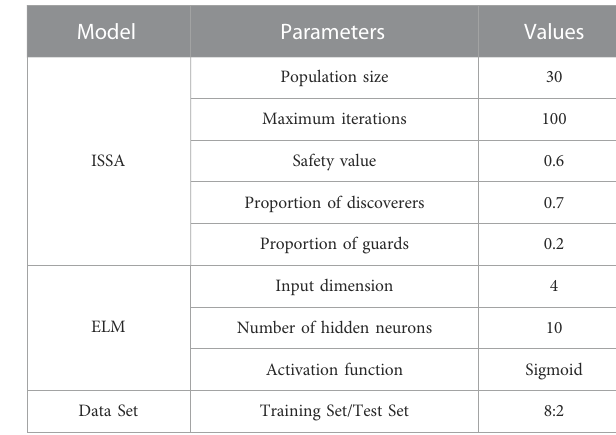
TABLE 3 Settings for the suggested model ’ s parameters.